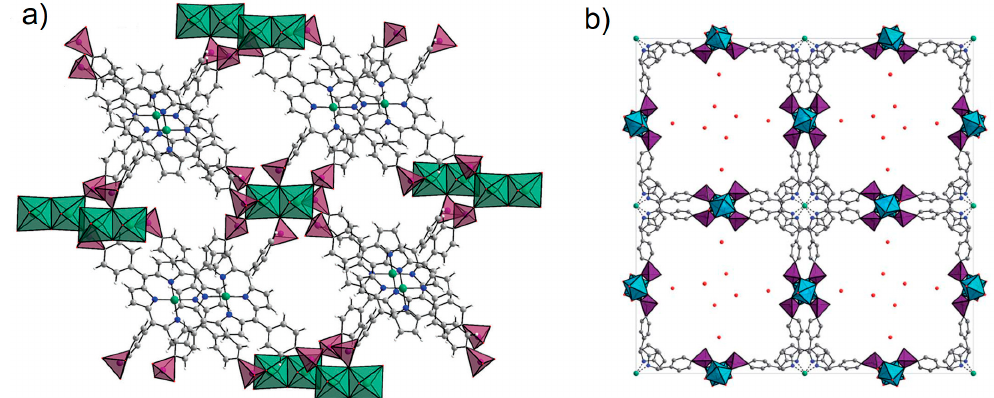
Figure 14. Crystal structures of ( a ) CAU-29 [Reprinted with permission from reference. [46]. Copyright 2018, Royal Society of Chemistry] and ( b ) CAU-30 [Reprinted with permission from reference [47]. Copyright 2018, Royal Society of Chemistry. Colour code: nickel: green, zirconium: light blue, phosphorus: purple, oxygen: red, nitrogen: dark blue, carbon: grey, hydrogen: white.